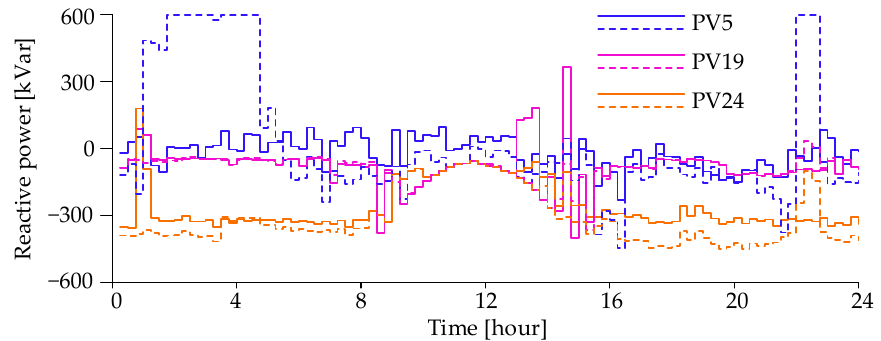
Figure 6. Day-ahead reactive power scheme of PV converters. Note that the positive value represents